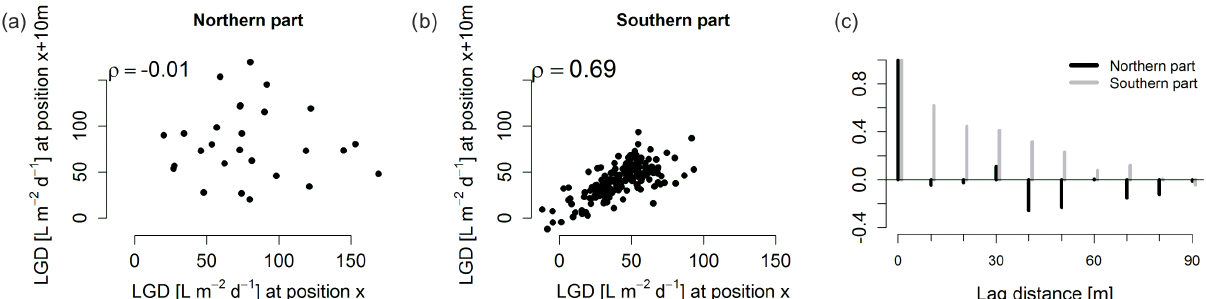
Figure 3. Correlation between neighbouring LGD measurement locations (distance 10m) in the northern part (a) and southern part (b) ; autocorrelogram for the LGD series of the northern and southern parts of the lake (c)